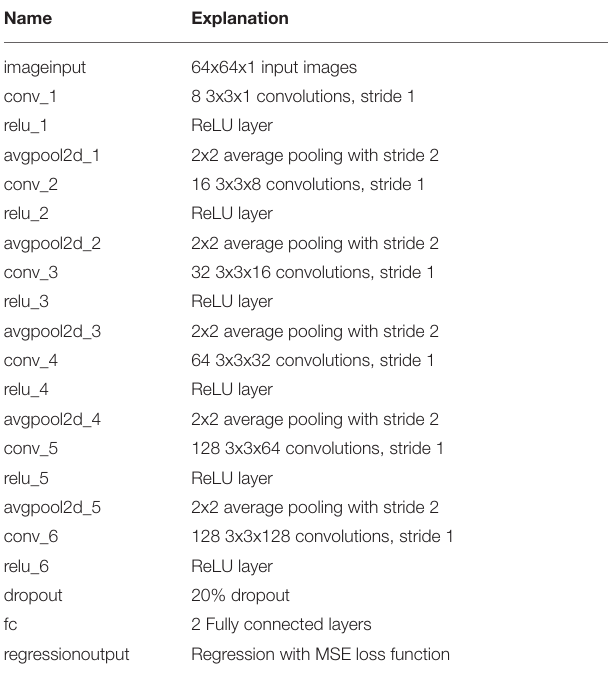
TABLE 1 | Topology of orientation estimation